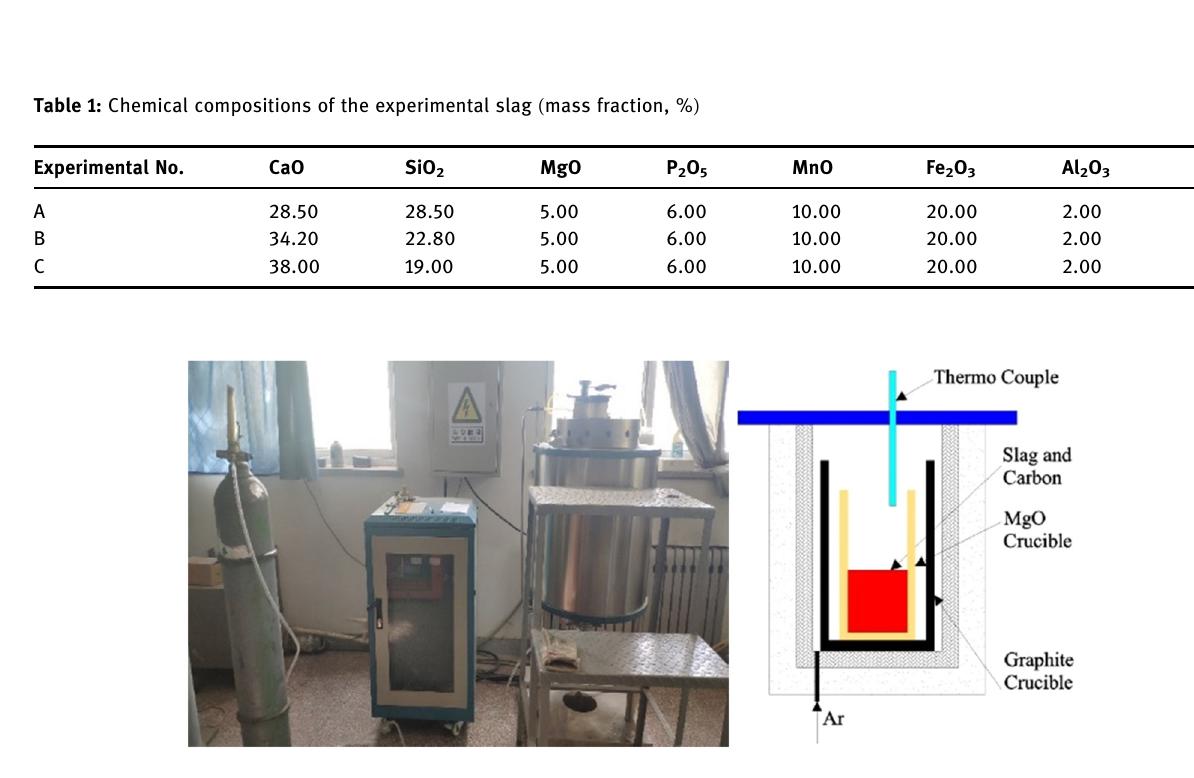
Figure 1: The image of the experimental equipment and schematic diagram of the resistance